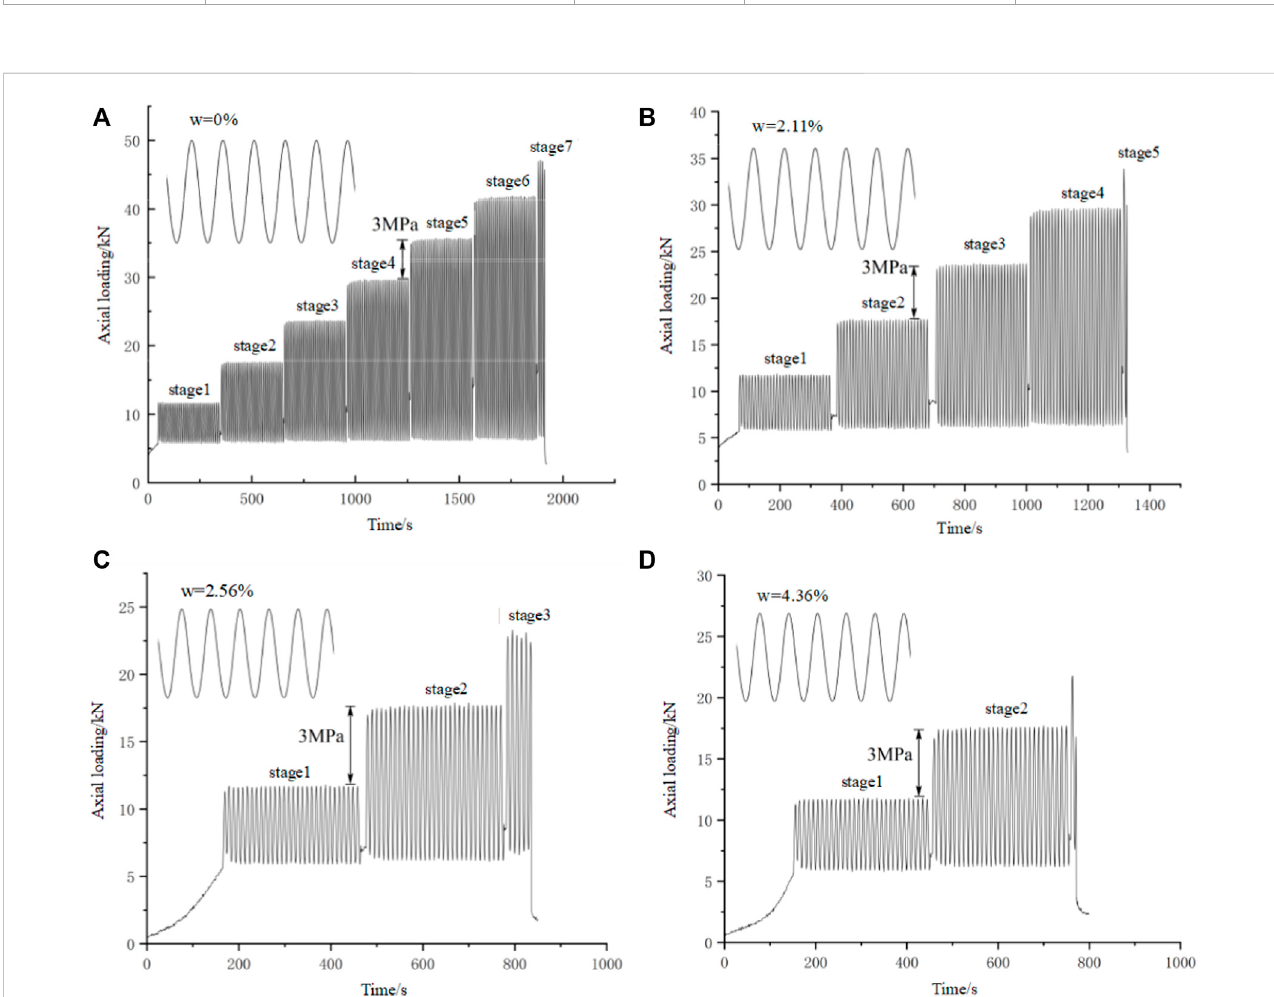
FIGURE 3 Speci fi c stress path with different dynamic frequency for the tested mud shale samples. (A-D) The water content is 0%, 2.21%, 2.56%, and 4.36%, respectively).